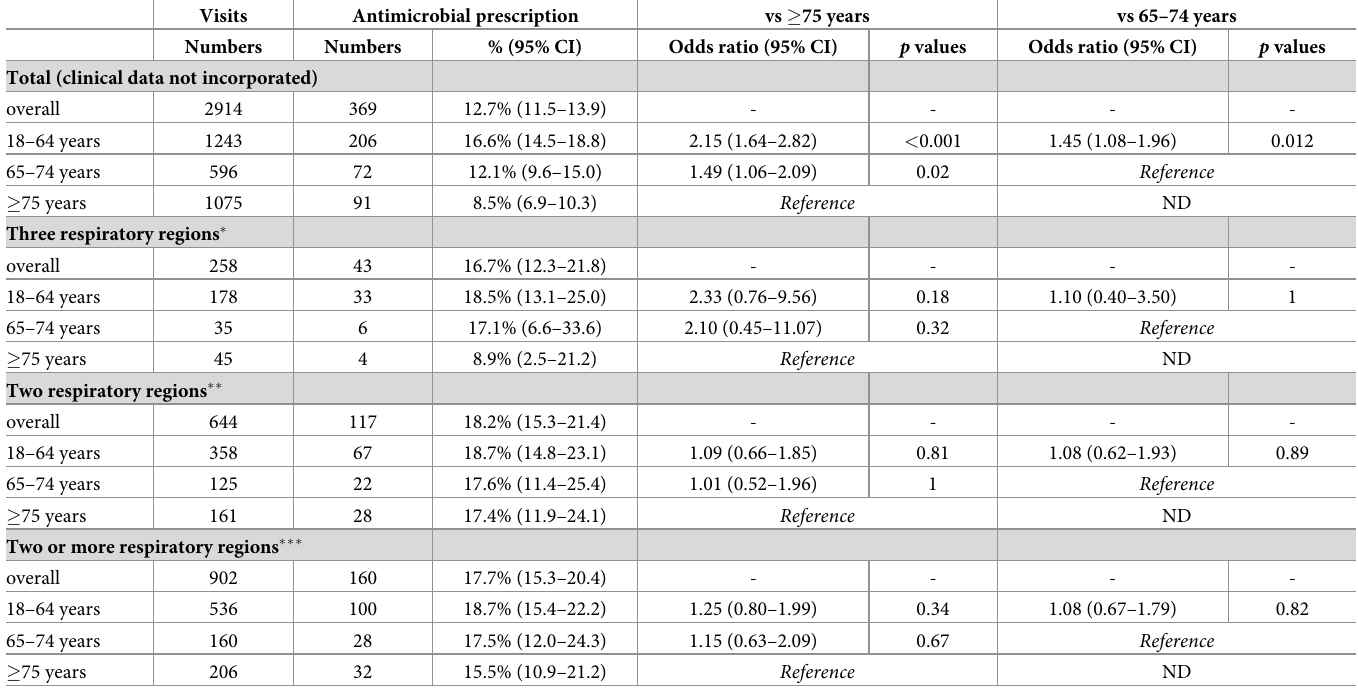
Table 2. Numbers and proportions of antimicrobial prescriptions for common cold according to clinical manifestations confirmed in the medical records and age groups. Visits Antimicrobial